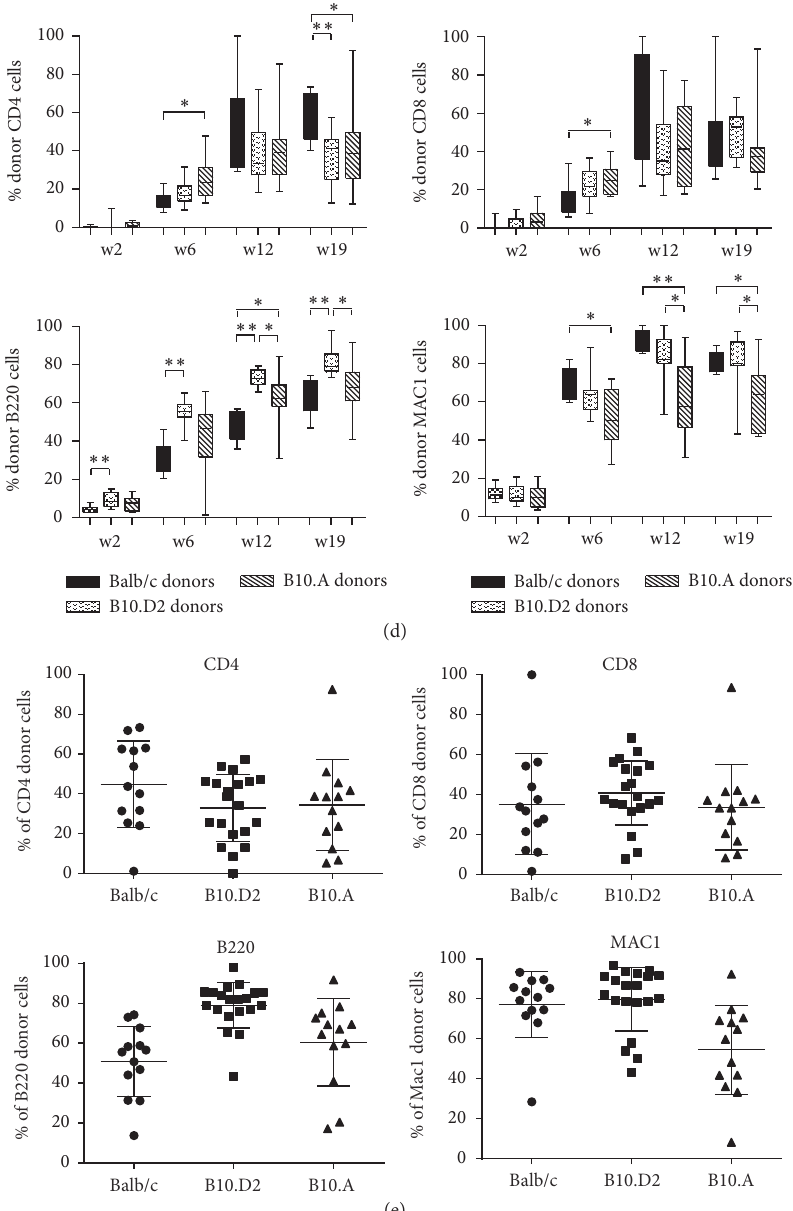
Figure 1: mHAg disparities impede rates of chimerism achieved through BMT with CB. (a) depicts the BMT protocol used with distinct donor-recipient combinations. (b) FACS plots show total donor (34-2-12 mAb recognizes H-Dd) and recipient type cells in CD4, CD8, B cells, and myeloid cells of one representative recipient of Balb/c BMC at the end of observation period. Dead cells were excluded through propidium iodide (PI) staining. (c) Rates of chimeras were determined at different time points after BMT. Early multilineage chimerism was induced in almost all mice. Maintenanceof chimerism was observed in all but one recipient mouse of MHC mismatched, but mHAg matched B10.D2 (H 2 d ) bone marrow throughout the observation period. In contrast, chimerism rates dropped in mice, which were transplanted with BMC of MHC and mHAg mismatched Balb/c (H 2 d ) mice over time similarly to mice, which received MHC mismatched but mHAg matched B10.A (H 2 a ) BMC ( 𝑝 < 0.05 for both versus B10.D2 BMC recipients after week 16). (d) Chimerism levels among CD4 cells, CD8 cells, B cells, and myeloid cells were measured by FCM at different time points after BMT. All groups of recipients showed relatively similar chimerism levels among T cell lineages throughout the observation period. Significantly higher chimerism was observed in B cells among recipients of MHCmismatched,butmHAgmatchedB10.D2(H 2 d )bonemarrowcomparedtomicetransplantedwithMHCandmHAgmismatchedBalb/c (H 2 d ) BMC ( ∗∗ 𝑝 < 0.01 at all measured time points). Myeloid cell chimerism was significantly lower in recipients of MHC mismatched, but mHAg matched B10.A (H 2 a ) after week 6 after BMT compared to recipients of Balb/c (H 2 d ) BMC ( ∗ 𝑝 < 0.05 and ∗∗ 𝑝 < 0.01 at indicated time points). Mean percent of chimerism, interquartile range (box), and SD (whiskers) of long-term chimeras are shown as box-and-whisker blots (representative data from 1 of 2 independent experiments). (e) Chimerism levels of long-term chimeras after transplantation of Balb/c BMC, B10.D2 BMC, or B10.A BMC, respectively, at the end of observation period. Individual percent, mean percent of chimerism, and SD (error bars) are shown as scatter plot (pooled data of two independent